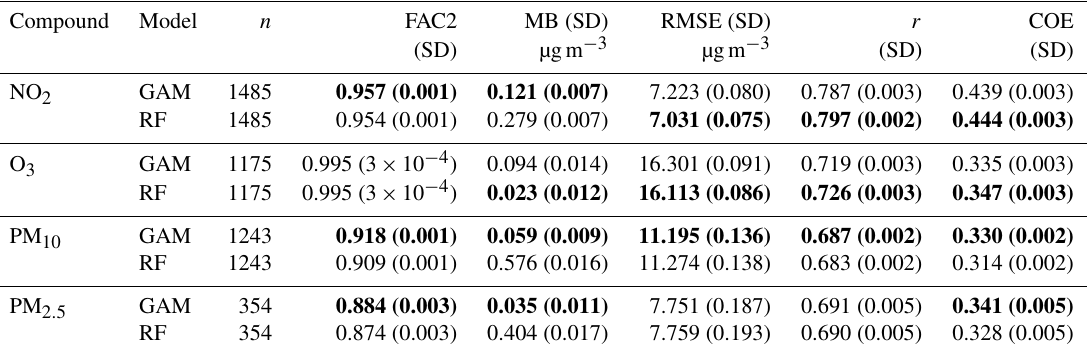
Table 2. Prediction accuracy from the cross-validation for 2005–2019 of AirGAM vs. RF from rmweather. The prediction performance metrics are the same as those used in Sect. 3. Values in bold mark the best-performing model for each compound and metric. Note: SD is the standard